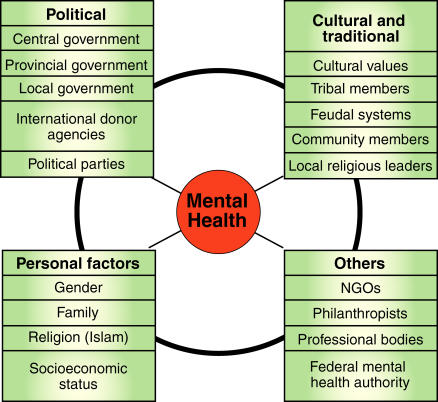
The Players and Factors Involved in the Access, Provision, Delivery, Functioning, and Uptake of Mental Health Services in Pakistan(Image: Aslam Bashir, Aga Khan University)